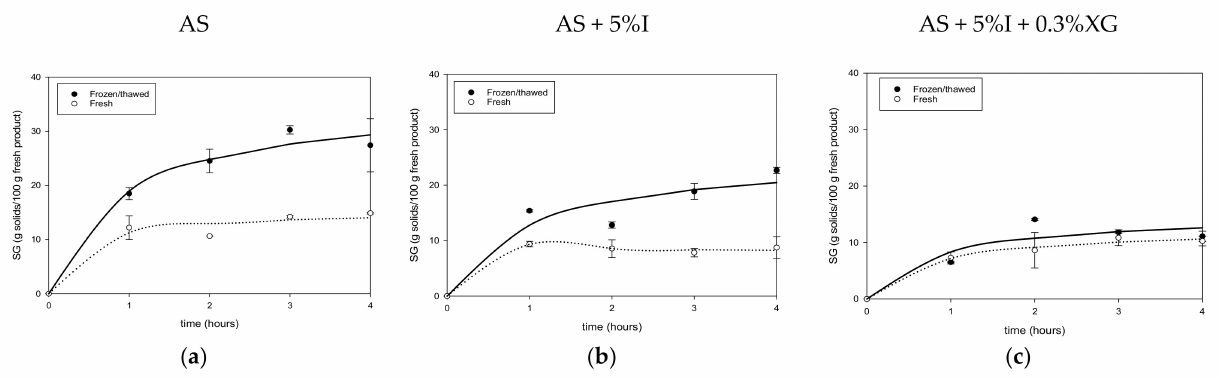
Figure 3. Solids gain of Fresh and F-T mango during osmotic dehydration in AS ( a ), AS + %I ( b ) and AS + %I + 0.3%XG ( c )